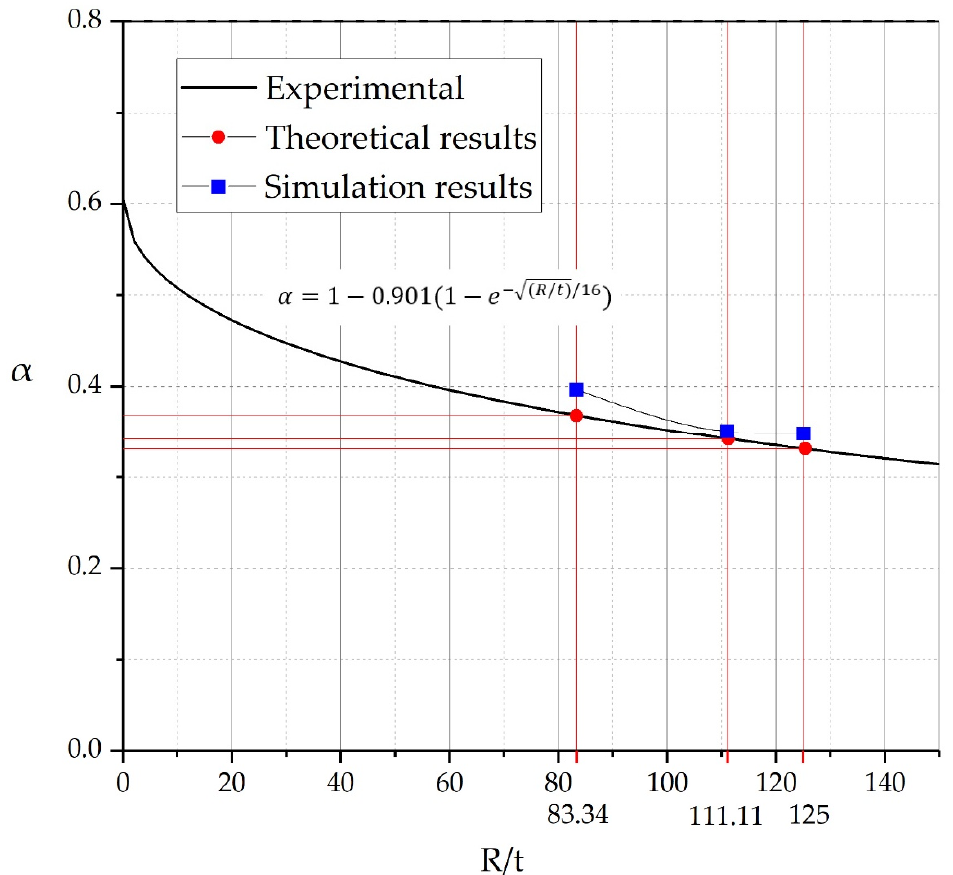
Figure 10. Imperfect shell knockdown factor of simulation results compared to experimental results conducted by NASA [55,56], selected range of R / t from 0 to 150.